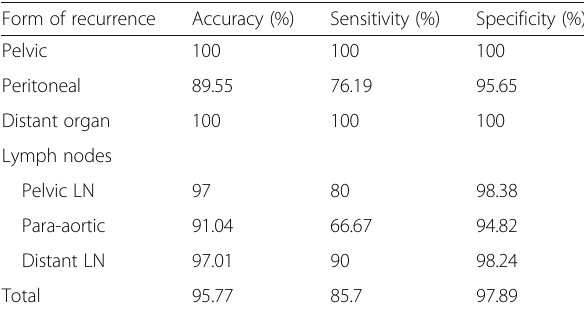
Table 2 PET/CT performance in the diagnosis of various recurrence forms of ovarian cancer